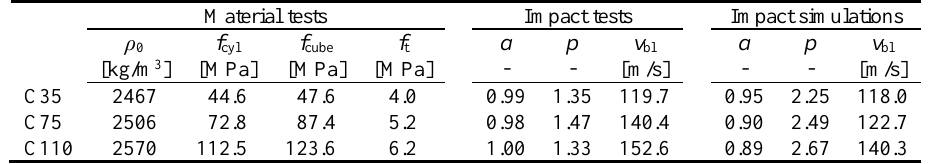
Fig. 1. Material test procedure where (a) shows the DIC setup, and the resulting engineering stress- strain curves for (b) cylinder compression, (c) cube compression and (d) tensile splitting tests. Table 1. Results from material tests, ballistic impact tests, and ballistic impact